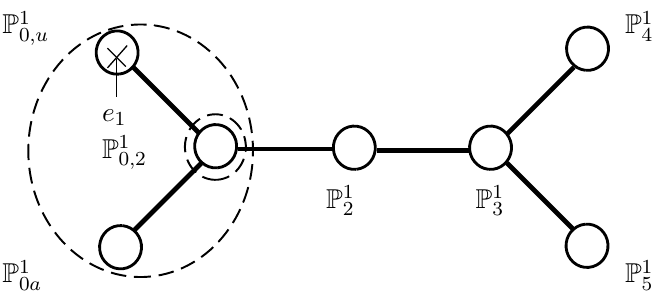
Figure 5 . Extended Dynkin diagram of SO(12) at the d 9 = 0 locus. The a(cid:14)ne node has an intersection with [ e 1 ]. The dashed circles indicate SO(10) nodes before the matter